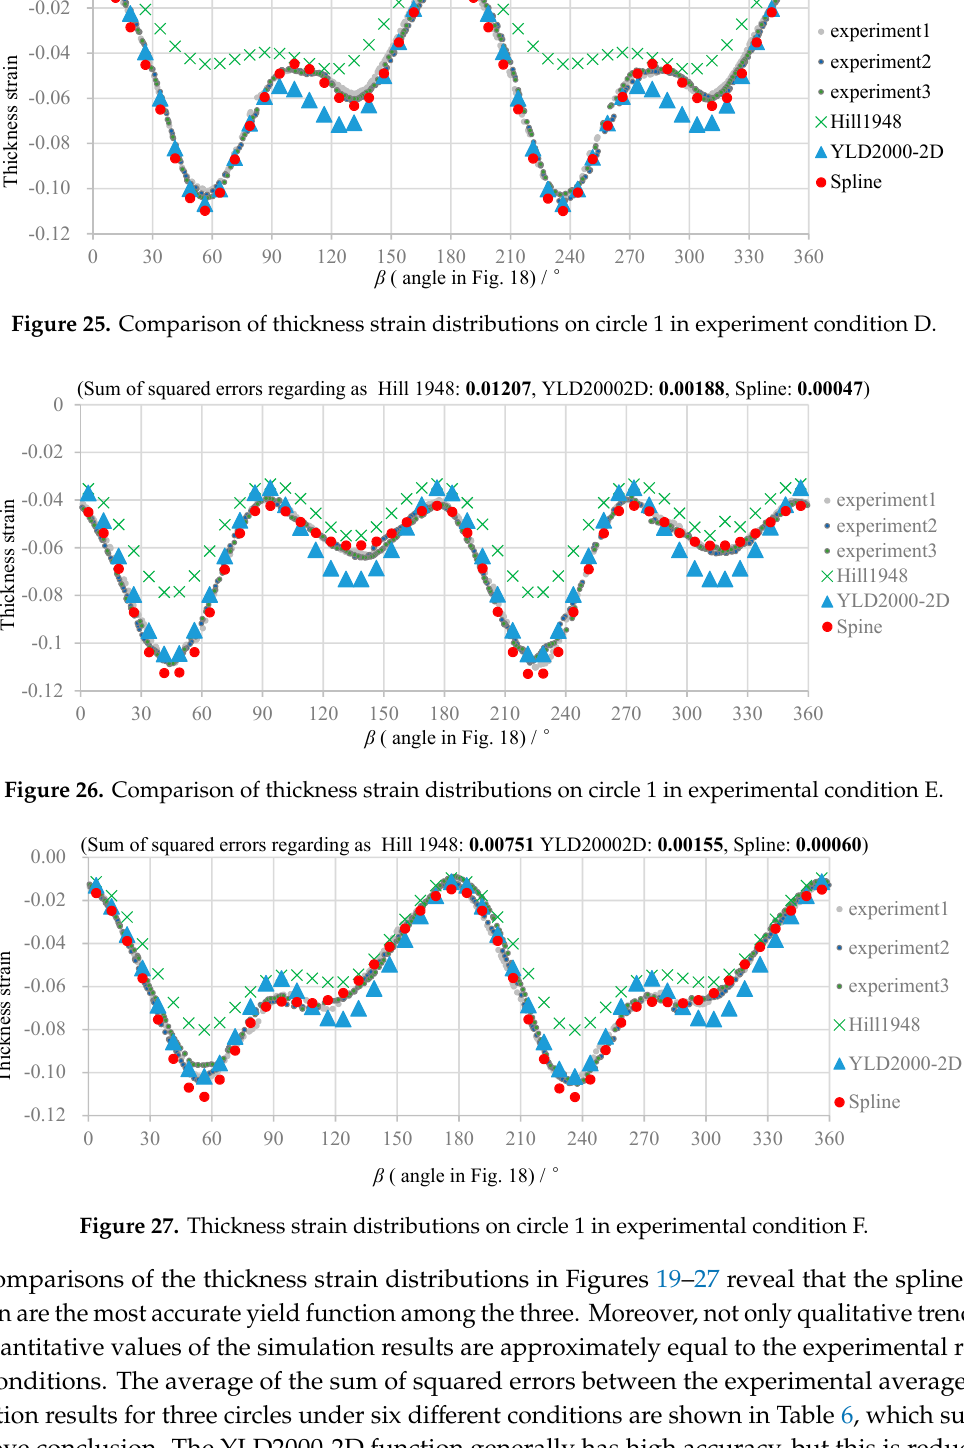
Figure 23. Comparison of thickness strain distributions on circle 2 in experimental condition B.